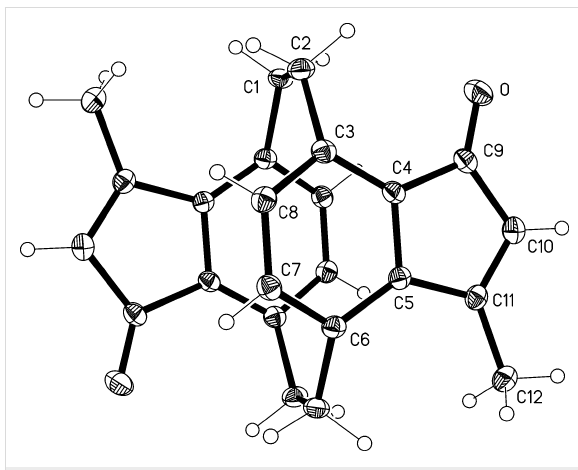
For 21 yellow single crystals were obtained by recrystallization from pentane/chloroform to allow their X-ray structure determination in the solid state. The results are shown in Figure 2. The molecule displays crystallographic inversion symmetry (which precludes the use of standard cyclophane numbering to some extent). It shows the same type of distor- tions as discussed above for 12 (see Table 2).